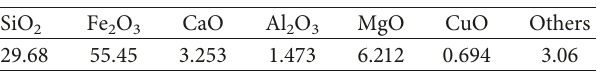
Figure 1: Features and size distribution of the copper-nickel slag. Table 1: Chemical composition (%) of the copper-nickel slag. Table 2: Mix proportions used in Experiment